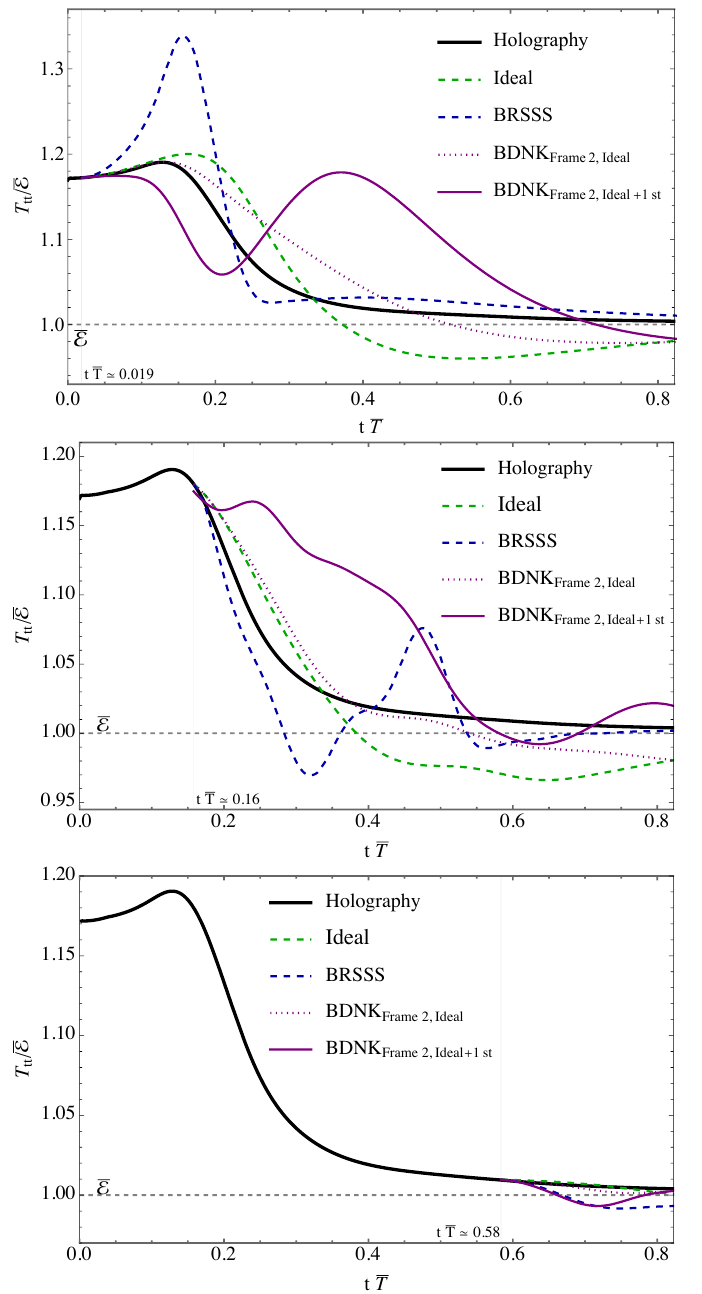
Figure 3 . Energy density in the lab frame, T tt , at an off center location { x, y } T = { 0 . 17 , 0 } as a function of time. Black continuous line corresponds to the microscopic (holographic) solution. We include the results of the hydrodynamic evolutions initialised with holographic data at tT ’ 0 . 019 , 0 . 16 , 0 . 58 , from top to bottom. For the BDNK evolutions, we also include the result of using only the 0th order terms (the ideal part) in (2.10), in dotted lines. The other components of the stress energy tensor behave in a quantitatively similar